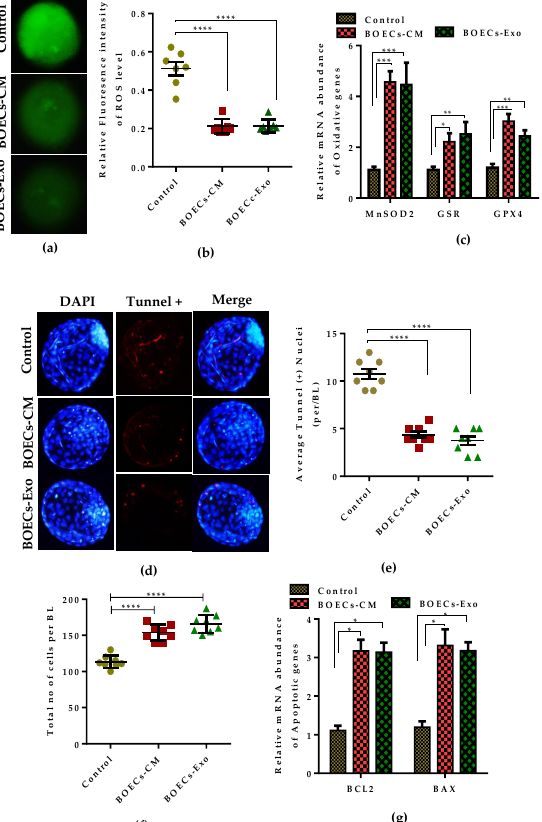
Figure 4. Effect of BOECs-CM and Exo supplementation on generation of ROS level and cell apoptotic index during bovine BL development. ( a ) DCHDFA staining showing the accumulation of ROS in day-8 BLs cultured in the presence of BOECs-CM and 3% Exo. ( b ) Bar graph data represents the quantification of fluorescence intensities. ( c ) Relative mRNA level of MnSOD1, GLUT1, and G6PD in control, BOECs-CM, and 3% Exo cultured groups. ( d ) Fluorescence images showing the TUNEL-positive cells (red) and DAPI (blue) in control, BOEC-CM, and 3% Exo supplemented groups. Apoptotic cells in nuclei are indicated with white arrows. ( e , f ) Bar graph data represents the average TUNEL ( + ) nuclei per BLs and total cell count in the indicated groups. ( g ) qRT-PCR analysis showing the expression of representative apoptotic genes in the indicated groups. Data presented as means ± SEM from triplicate experiments with (n = 15 BLs) per group in individual set of ROS and TUNEL assays. For mRNA expression analysis n = 5 BLs / group used in triplicate experiments. * p < 0.05; ** p < 0.01; *** p < 0.001; **** p < 0.0001 indicates significant di ff erence. Original magnification of representative images is 100 ×